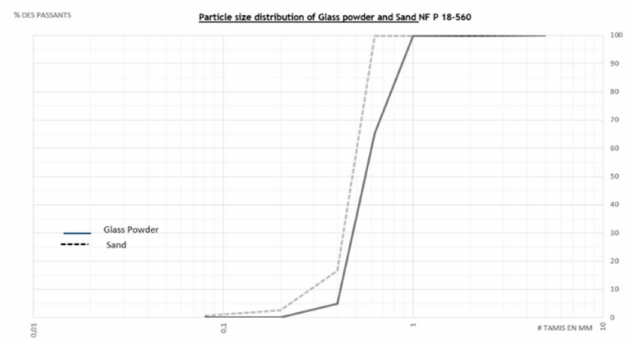
Figure 2. Particle size distribution of glass powder and